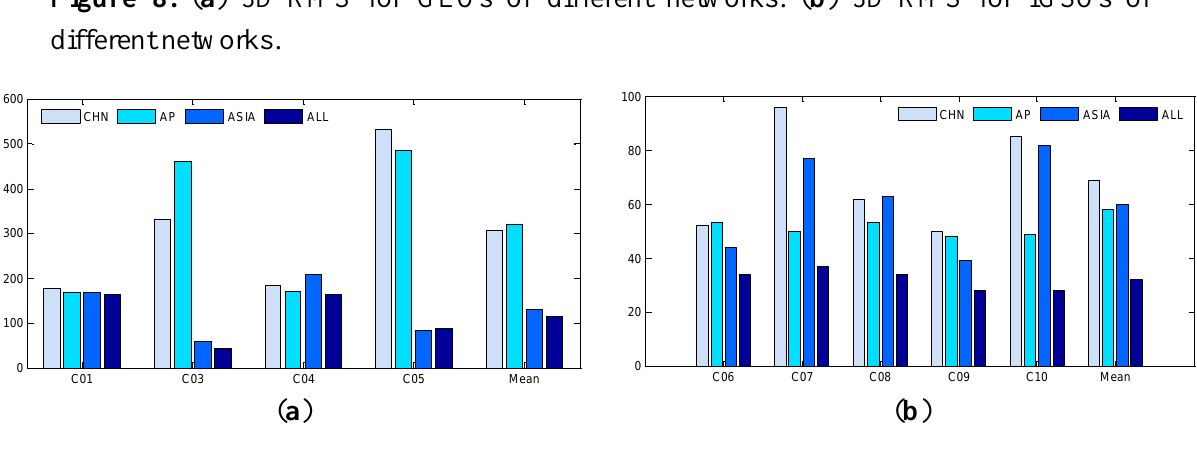
Figure 8. ( a ) 3D-RMS for GEOs of different networks. ( b ) 3D-RMS for IGSOs